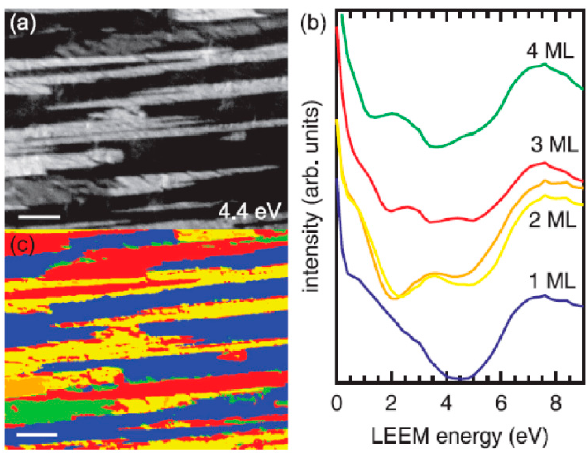
Figure 35. ( a ) LEEM bright-field image at E LEEM = 4.4 eV of graphene on 4H-SiC(1120). ( b ) Typical reflectivity spectra offset from each other for clarity. ( c ) False color image of same area as in ( a ) colored corresponding to the spectra shown in ( b ). The length of the scale bar is 1 µm [144].